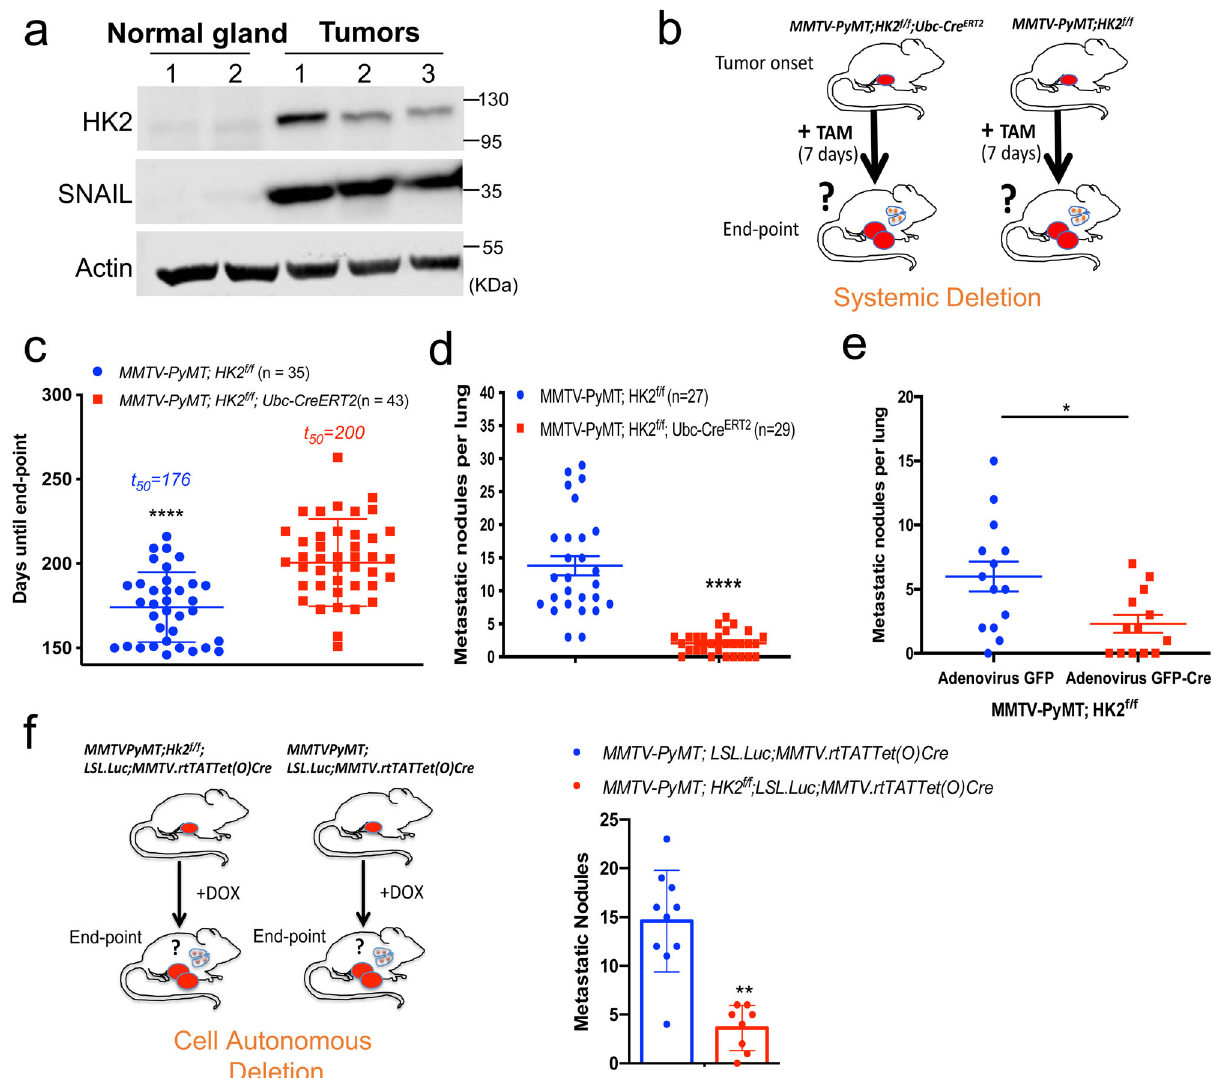
Fig. 6 Systemic and cell autonomous deletion of HK2 inhibits metastasis to the lung in MMTV-PyMT mice. a Immunoblot image of HK2 and SNAIL protein levels in tissue samples collected from normal mammary glands from two different female mice and primary mammary gland tumors from three different female mice. b Schematic illustration depicting the experimental approach for systemic deletion of HK2 in MMTV-PyMT mouse model. Once a primary tumor was palpable, tamoxifen (TAM) was injected for 7 consecutive days in MMTV-PyMT; HK2 f/f ; UBC-Cre ERT2 and MMTV-PyMT; HK2 f/f mice. At endpoint, mice were euthanized and lung metastasis was quanti fi ed. c Tumor endpoint analysis in MMTV -PyMT; HK2 f/f ; UBC-Cre ERT2 and MMTV-PyMT; HK2 f/f mice with TAM injection at tumor onset. Results are the mean ± SEM; **** p < 0.0001 or (or p = 5.48E-06) using unpaired two-tailed t -test. d Incidence of metastatic lesions in the lungs. When tumors reached endpoint, the mice were euthanized, and metastatic lesions in the lungs were quanti fi ed. Results are the mean ± SEM; **** p < 0.0001 (or p = 7.2186E-11) using unpaired two-tailed t -test. e Cell-autonomous deletion of HK2 impairs lung metastasis. Isolated MMTV-PyMT;HK2 f/f mammary tumor cells were treated with GFP-Cre adenovirus to delete HK2 or GFP adenovirus as a control. After 72 h, the cells were transplanted into the mammary fat pads of recipient immunode fi cient NOG mice. At the endpoint, mice were euthanized, and lung metastatic lesions were quanti fi ed. The results are the mean ± SEM; * p = 0.013 using unpaired two-tailed t -test with ( n = 13 biologically independent animals with MMTV-PyMT;HK2 f/f GFP-Cre adenovirus cells and n = 14 biologically independent animals with MMTV-PyMT;HK2 f/f GFP adenovirus). f Upper panel: schematic showing experimental design. MMTV-PyMT;HK2 f/f ;LSL.Luc;MMTV.rtTATet(O)Cre and control MMTV-PyMT;LSL.Luc;MMTV.rtTATet(O)Cre mice were subjected to DOX diet after tumor onset and metastasis was quanti fi ed at endpoint. Bottom panel: quanti fi cation of metastasis to the lung. The results are the mean ± SEM; ** p = 0.0038 using one-way. ANOVA. ( n = 10 for MMTV-PyMT;LSL.Luc;MMTV.rtTA;Tet(O)Cre mice and n = 8 for MMTV- PyMT;HK2 f/f ;LSL.Luc;MMTV.rtTA;Tet(O)Cre mice). Uncropped blots are provided as a Supplementary Fig. 16. Source data are provided as a Source Data fi